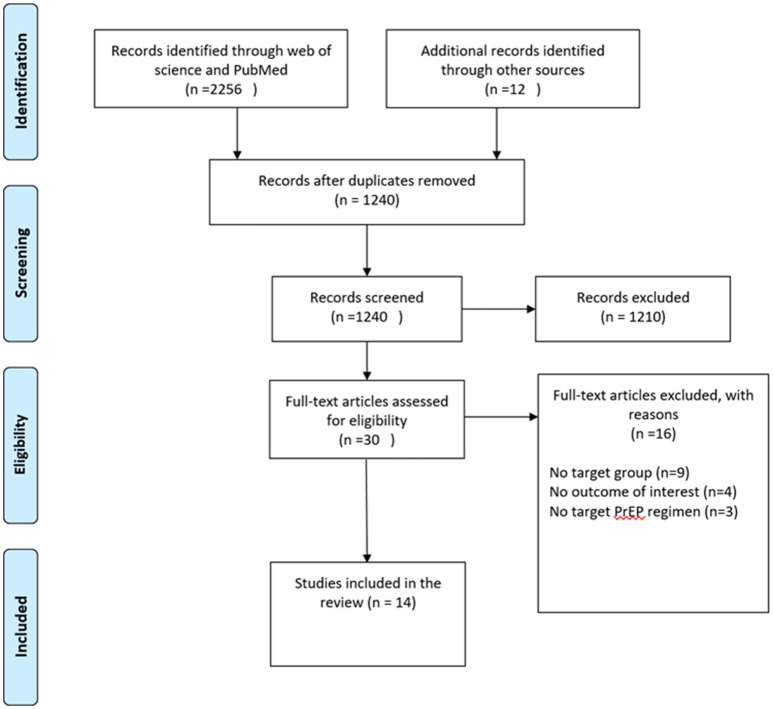
Flow diagram of this systematic review and meta-analysis.